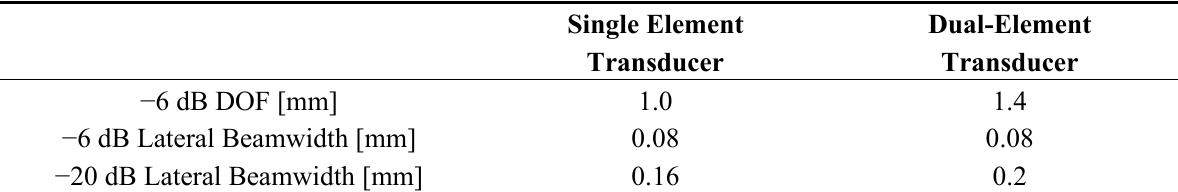
Table 2. Simulation results for the single element and dual-element